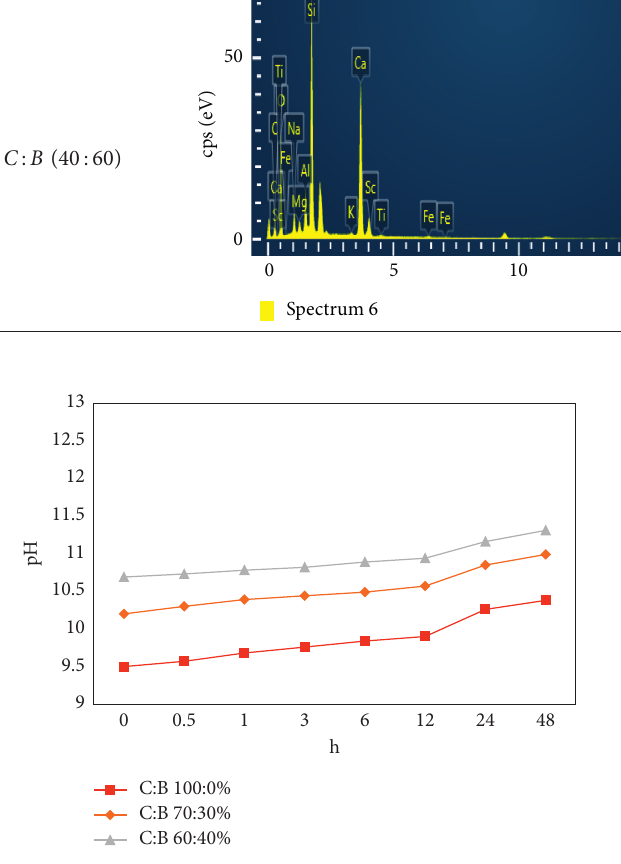
Figure 9: Findings from pH test.